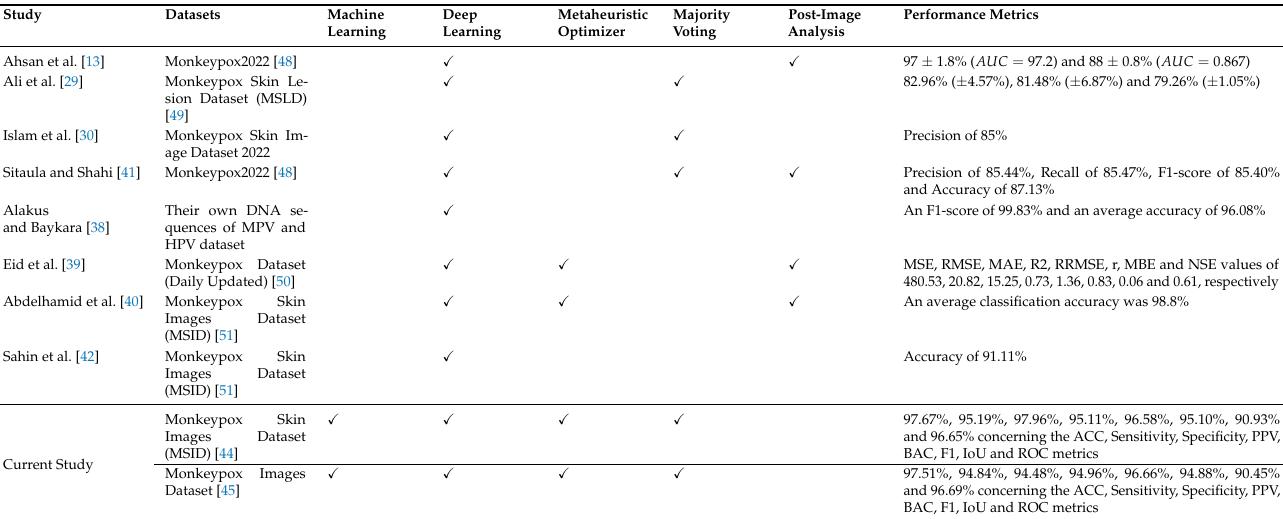
Table 10. Comparison between the suggested approach and related